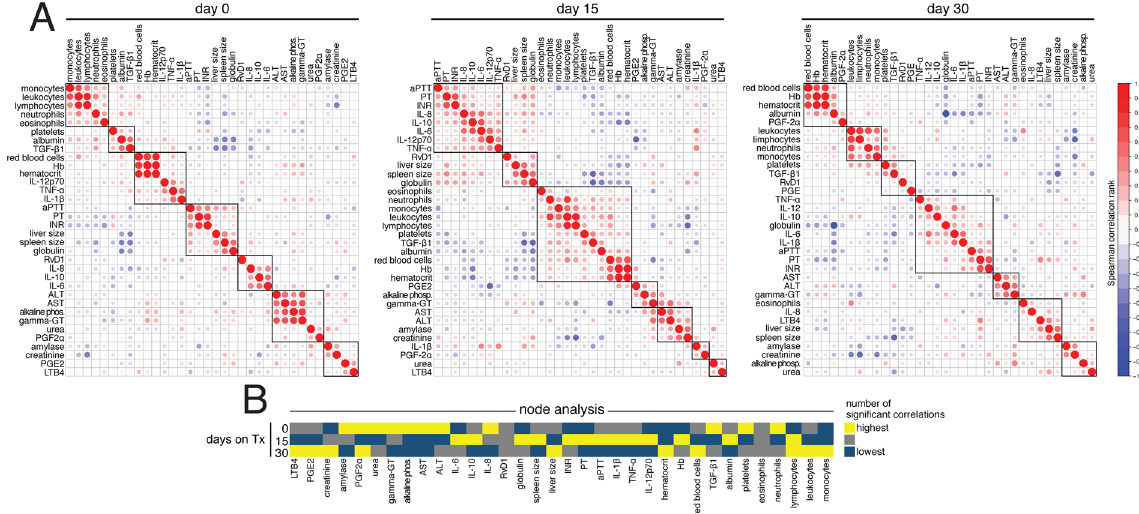
Figure 2. Correlation profile of inflammation and disease parameters in VL patients undergoing leishmanicidal therapy. ( A ) Heatmap shows significant correlation (p < 0.05, after adjustment for multiple measurements) of clustered Spearman matrices including serum cytokines, lipid mediators, as well as clinical, hematological, and laboratory parameters in VL patients at indicated timepoints of leishmanicidal therapy. A heatmap using the Spearman rank values was used to illustrate the matrices and only statistically significant correlations are shown. ( B ) A heatmap of the number of significant correlations involving each parameter examined is